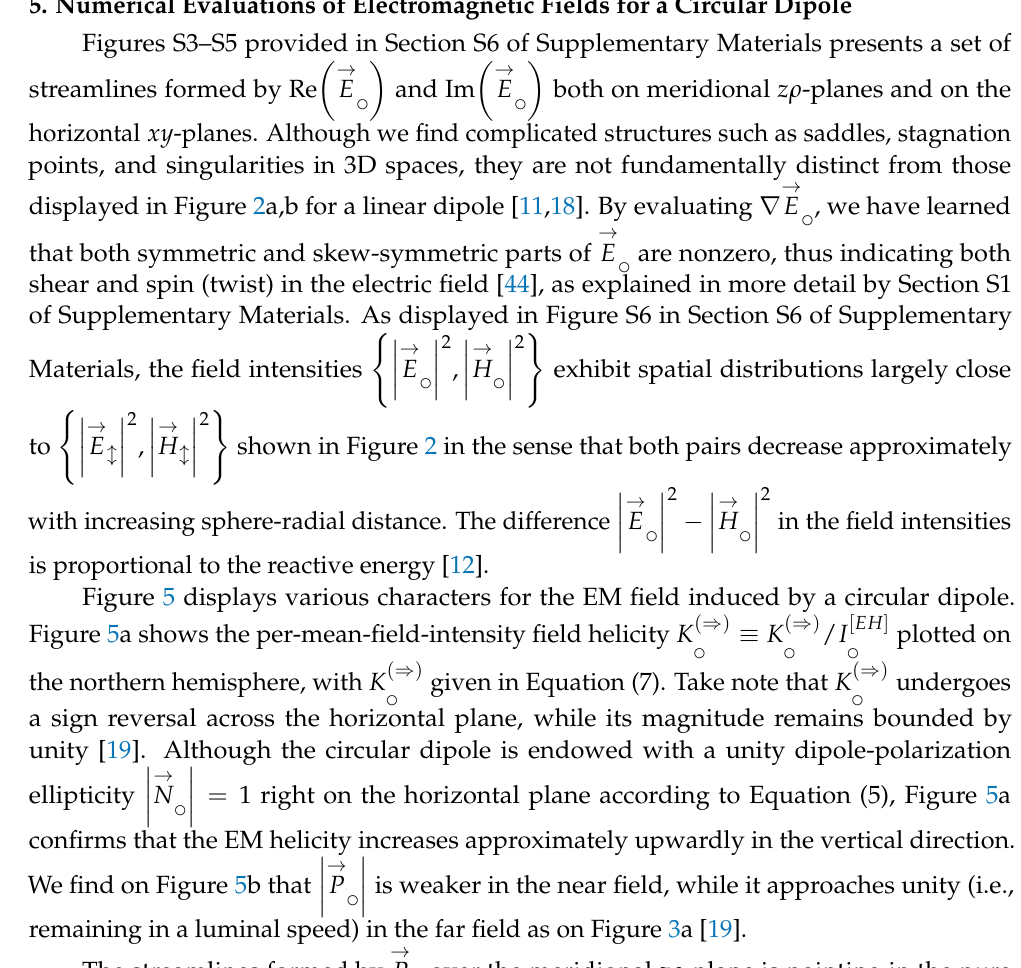
    Figure 1. ( a ) Decomposition of a Poynting vector P into an orbital energy flux O and a spin Figure 1. ( a ) Decomposition of a Poynting vector P into an orbital energy flux O and a spin     energy flux S energy flux S . Besides, M is a spin angular momentum (SAM) density. ( b ) The coordinate . Besides, M is a spin angular momentum (SAM) density. ( b ) The coordinate systems. On the origin lies a primary electric point dipole represented by its unit vector ˆ p . ( c ) A systems. On the origin lies a primary electric point dipole represented by its unit vector ˆ p . ( c ) A   linear dipole ˆ p with its dipole axis lying parallel to the vertical axis leads to a pencil-hull-like linear dipole ˆ p with its dipole axis lying parallel to the vertical axis leads to a pencil-hull-like   Figure 1. ( a ) Decomposition of a Poynting vector P into an orbital energy flux O and a spin   tapered cylindrical surface designating higher values for the degree of circular polarization (DoCP). tapered cylindrical surface designating higher values for the degree of circular polarization (DoCP).   energy flux S . Besides, M is a spin angular momentum (SAM) density. ( b ) The coordinate Figure 1. ( a ) Decomposition of a Poynting vector P into an orbital energy flux O and a spin with its dipole axis lying on the horizontal plane leads to a filled solid with its dipole axis lying on the horizontal plane leads to a filled solid ( d ) A circular dipole ˆ p ( d ) A circular dipole ˆ p     systems. On the origin lies a primary electric point dipole represented by its unit vector ˆ p . ( c ) A energy flux S . Besides, M is a spin angular momentum (SAM) density. ( b ) The coordinate ○ ○ cone of higher values of DoCP. cone of higher values of DoCP. linear dipole ˆ p with its dipole axis lying parallel to the vertical axis leads to a pencil-hull-like   systems. On the origin lies a primary electric point dipole represented by its unit vector ˆ p . ( c ) A  tapered cylindrical surface designating higher values for the degree of circular polarization (DoCP).     linear dipole ˆ p with its dipole axis lying parallel to the vertical axis leads to a pencil-hull-like  Figure 1. ( a ) Decomposition of a Poynting vector P into an orbital energy flux O and a spin Figure 1. ( a ) Decomposition of a Poynting vector P into an orbital energy flux O and a spin with its dipole axis lying on the horizontal plane leads to a filled solid ( d ) A circular dipole ˆ p      tapered cylindrical surface designating higher values for the degree of circular polarization (DoCP). energy flux S energy flux S . Besides, M is a spin angular momentum (SAM) density. ( b ) The coordinate . Besides, M is a spin angular momentum (SAM) density. ( b ) The coordinate ○ cone of higher values of DoCP. with its dipole axis lying on the horizontal plane leads to a filled solid ( d ) A circular dipole ˆ p   systems. On the origin lies a primary electric point dipole represented by its unit vector ˆ p . ( c ) A systems. On the origin lies a primary electric point dipole represented by its unit vector ˆ p . ( c ) A ○ cone of higher values of DoCP. linear dipole ˆ p with its dipole axis lying parallel to the vertical axis leads to a pencil-hull-like linear dipole ˆ p with its dipole axis lying parallel to the vertical axis leads to a pencil-hull-like        tapered cylindrical surface designating higher values for the degree of circular polarization (DoCP). tapered cylindrical surface designating higher values for the degree of circular polarization (DoCP). Figure 1. ( a ) Decomposition of a Poynting vector P into an orbital energy flux O and a spin Figure 1. ( a ) Decomposition of a Poynting vector P into an orbital energy flux O and a spin     with its dipole axis lying on the horizontal plane leads to a filled solid with its dipole axis lying on the horizontal plane leads to a filled solid ( d ) A circular dipole ˆ p ( d ) A circular dipole ˆ p   energy flux S energy flux S . Besides, M is a spin angular momentum (SAM) density. ( b ) The coordinate . Besides, M is a spin angular momentum (SAM) density. ( b ) The coordinate ○ ○ cone of higher values of DoCP. cone of higher values of DoCP. systems. On the origin lies a primary electric point dipole represented by its unit vector ˆ p . ( c ) A systems. On the origin lies a primary electric point dipole represented by its unit vector ˆ p . ( c ) A         linear dipole ˆ p with its dipole axis lying parallel to the vertical axis leads to a pencil-hull-like linear dipole ˆ p with its dipole axis lying parallel to the vertical axis leads to a pencil-hull-like   Figure 1. ( a ) Decomposition of a Poynting vector P into an orbital energy flux O and a spin Figure 1. ( a ) Decomposition of a Poynting vector P into an orbital energy flux O and a spin Figure 1. ( a ) Decomposition of a Poynting vector P into an orbital energy flux O and a spin       tapered cylindrical surface designating higher values for the degree of circular polarization (DoCP). tapered cylindrical surface designating higher values for the degree of circular polarization (DoCP).     energy flux S energy flux S energy flux S . Besides, M is a spin angular momentum (SAM) density. ( b ) The coordinate . Besides, M is a spin angular momentum (SAM) density. ( b ) The coordinate . Besides, M is a spin angular momentum (SAM) density. ( b ) The coordinate Figure 1. ( a ) Decomposition of a Poynting vector P into an orbital energy flux O and a spin Figure 1. ( a ) Decomposition of a Poynting vector P into an orbital energy flux O and a spin with its dipole axis lying on the horizontal plane leads to a filled solid with its dipole axis lying on the horizontal plane leads to a filled solid ( d ) A circular dipole ˆ p ( d ) A circular dipole ˆ p       systems. On the origin lies a primary electric point dipole represented by its unit vector ˆ p . ( c ) A systems. On the origin lies a primary electric point dipole represented by its unit vector ˆ p . ( c ) A systems. On the origin lies a primary electric point dipole represented by its unit vector ˆ p . ( c ) A energy flux S energy flux S . Besides, M is a spin angular momentum (SAM) density. ( b ) The coordinate . Besides, M is a spin angular momentum (SAM) density. ( b ) The coordinate ○ ○ cone of higher values of DoCP. cone of higher values of DoCP.   linear dipole ˆ p with its dipole axis lying parallel to the vertical axis leads to a pencil-hull-like linear dipole ˆ p with its dipole axis lying parallel to the vertical axis leads to a pencil-hull-like linear dipole ˆ p with its dipole axis lying parallel to the vertical axis leads to a pencil-hull-like systems. On the origin lies a primary electric point dipole represented by its unit vector ˆ p . ( c ) A systems. On the origin lies a primary electric point dipole represented by its unit vector ˆ p . ( c ) A      tapered cylindrical surface designating higher values for the degree of circular polarization (DoCP). tapered cylindrical surface designating higher values for the degree of circular polarization (DoCP). tapered cylindrical surface designating higher values for the degree of circular polarization (DoCP). linear dipole ˆ p with its dipole axis lying parallel to the vertical axis leads to a pencil-hull-like linear dipole ˆ p with its dipole axis lying parallel to the vertical axis leads to a pencil-hull-like Figure 1. ( a ) Decomposition of a Poynting vector P into an orbital energy flux O and a spin plotted on    with its dipole axis lying on the horizontal plane leads to a filled solid with its dipole axis lying on the horizontal plane leads to a filled solid with its dipole axis lying on the horizontal plane leads to a filled solid ( d ) A circular dipole ˆ p ( d ) A circular dipole ˆ p ( d ) A circular dipole ˆ p     tapered cylindrical surface designating higher values for the degree of circular polarization (DoCP). tapered cylindrical surface designating higher values for the degree of circular polarization (DoCP). energy flux S . Besides, M is a spin angular momentum (SAM) density. ( b ) The coordinate ○ ○ ○ cone of higher values of DoCP. cone of higher values of DoCP. cone of higher values of DoCP. with its dipole axis lying on the horizontal plane leads to a filled solid with its dipole axis lying on the horizontal plane leads to a filled solid ( d ) A circular dipole ˆ p ( d ) A circular dipole ˆ p    systems. On the origin lies a primary electric point dipole represented by its unit vector ˆ p . ( c ) A     Figure 1. ( a ) Decomposition of a Poynting vector P into an orbital energy flux O and a spin ○ ○ cone of higher values of DoCP. cone of higher values of DoCP.  linear dipole ˆ p with its dipole axis lying parallel to the vertical axis leads to a pencil-hull-like     energy flux S . Besides, M is a spin angular momentum (SAM) density. ( b ) The coordinate tapered cylindrical surface designating higher values for the degree of circular polarization (DoCP).   systems. On the origin lies a primary electric point dipole represented by its unit vector ˆ p . ( c ) A = 1 right on the horizontal plane according to Equation (5), Figure 5a with its dipole axis lying on the horizontal plane leads to a filled solid ( d ) A circular dipole ˆ p Figure 1. ( a ) Decomposition of a Poynting vector P into an orbital energy flux O and a spin (cid:12)    linear dipole ˆ p with its dipole axis lying parallel to the vertical axis leads to a pencil-hull-like  ○ cone of higher values of DoCP. energy flux S . Besides, M is a spin angular momentum (SAM) density. ( b ) The coordinate    tapered cylindrical surface designating higher values for the degree of circular polarization (DoCP). Figure 1. ( a ) Decomposition of a Poynting vector P into an orbital energy flux O and a spin systems. On the origin lies a primary electric point dipole represented by its unit vector ˆ p . ( c ) A   energy flux S . Besides, M is a spin angular momentum (SAM) density. ( b ) The coordinate linear dipole ˆ p with its dipole axis lying parallel to the vertical axis leads to a pencil-hull-like    systems. On the origin lies a primary electric point dipole represented by its unit vector ˆ p . ( c ) A Figure 1. ( a ) Decomposition of a Poynting vector P into an orbital energy flux O and a spin   tapered cylindrical surface designating higher values for the degree of circular polarization (DoCP).   H M M ∇ + ∇ =   of the total SAM density is nothing but the helicity conservation linear dipole ˆ p with its dipole axis lying parallel to the vertical axis leads to a pencil-hull-like energy flux S . Besides, M is a spin angular momentum (SAM) density. ( b ) The coordinate with its dipole axis lying on the horizontal plane leads to a filled solid ( d ) A circular dipole ˆ p     law for time-oscillatory fields [30]. Figure 1a illustrates this conservation law. systems. On the origin lies a primary electric point dipole represented by its unit vector ˆ p . ( c ) A Figure 1. ( a ) Decomposition of a Poynting vector P into an orbital energy flux O and a spin tapered cylindrical surface designating higher values for the degree of circular polarization (DoCP). ○ cone of higher values of DoCP.    with its dipole axis lying on the horizontal plane leads to a filled solid ( d ) A circular dipole ˆ p linear dipole ˆ p with its dipole axis lying parallel to the vertical axis leads to a pencil-hull-like energy flux S . Besides, M is a spin angular momentum (SAM) density. ( b ) The coordinate     systems. On the origin lies a primary electric point dipole represented by its unit vector ˆ p . ( c ) A ○ tapered cylindrical surface designating higher values for the degree of circular polarization (DoCP). cone of higher values of DoCP. Figure 1. ( a ) Decomposition of a Poynting vector P into an orbital energy flux O and a spin    with its dipole axis lying on the horizontal plane leads to a filled solid ( d ) A circular dipole ˆ p linear dipole ˆ p with its dipole axis lying parallel to the vertical axis leads to a pencil-hull-like energy flux S . Besides, M is a spin angular momentum (SAM) density. ( b ) The coordinate   ○ tapered cylindrical surface designating higher values for the degree of circular polarization (DoCP). cone of higher values of DoCP. systems. On the origin lies a primary electric point dipole represented by its unit vector ˆ p . ( c ) A  with its dipole axis lying on the horizontal plane leads to a filled solid ( d ) A circular dipole ˆ p linear dipole ˆ p with its dipole axis lying parallel to the vertical axis leads to a pencil-hull-like   ○ cone of higher values of DoCP. tapered cylindrical surface designating higher values for the degree of circular polarization (DoCP).  with its dipole axis lying on the horizontal plane leads to a filled solid ( d ) A circular dipole ˆ p  ○ cone of higher values of DoCP. 